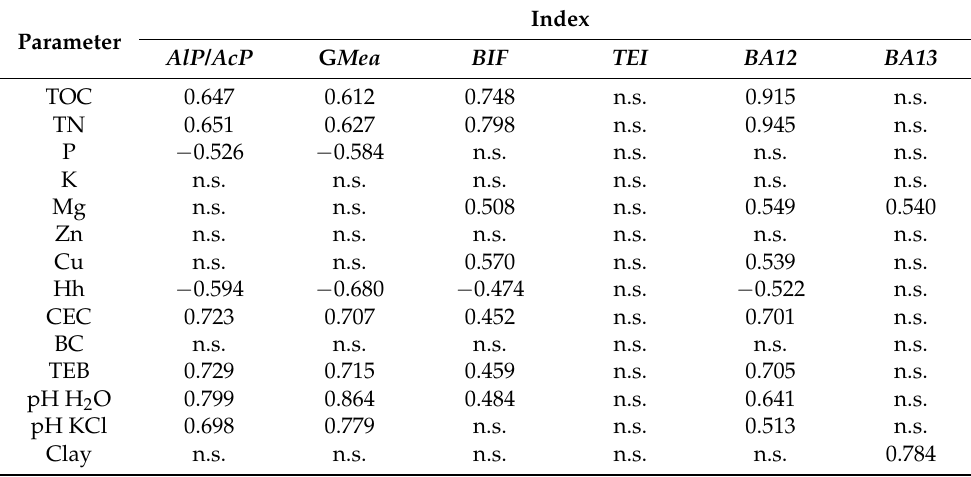
Table 4. Relations between the activity of selected enzyme indices and soil